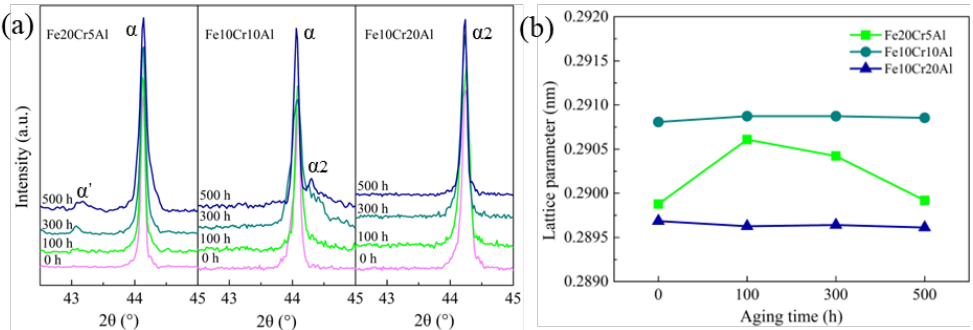
Figure 4. ( a ) The (110) diffraction profiles and ( b ) lattice parameters of porous Fe-Cr-Al materials after aging for different times.